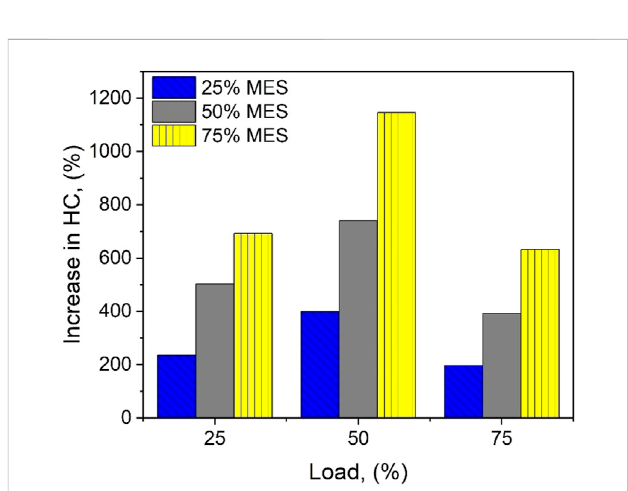
FIGURE 7 Percentage change inHC emissions with respect to diesel fuel with varying MES level at different